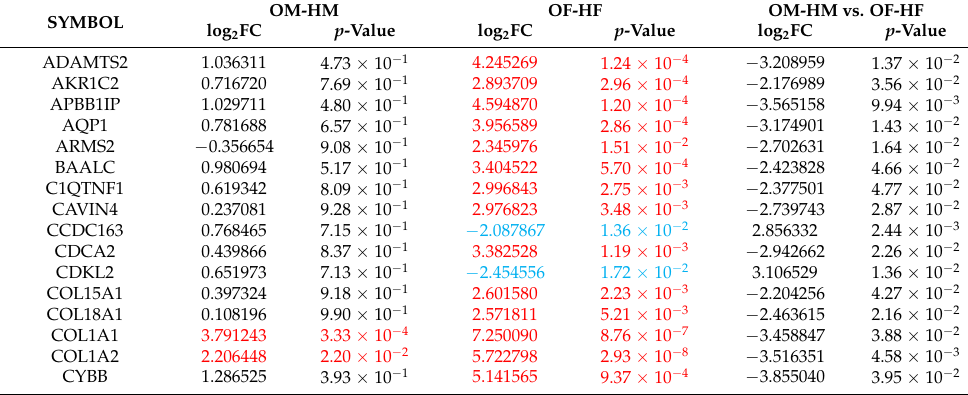
Table 4. OA-responsive DEGs that have significantly different expression fold changes between males and females, and significantly ( p < 0.05) altered in at least one gender. DEGs significantly upregulated in response to OA are highlighted in red, and those significantly downregulated in blue. OM-HM SYMBOL